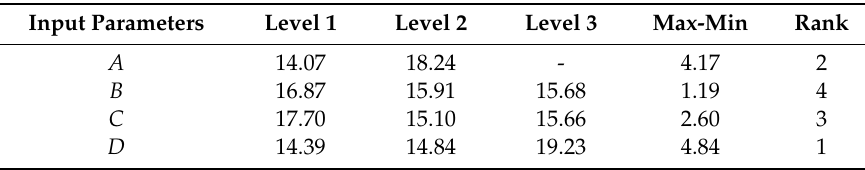
Table 11. ANOM results for S / N ratio.